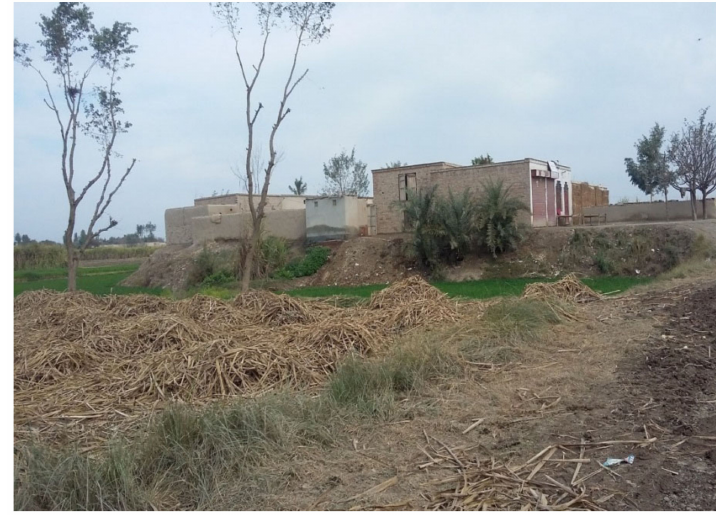
Figure 16. Practice of raised plinth level in flood-prone communities of LN, district Layyah.